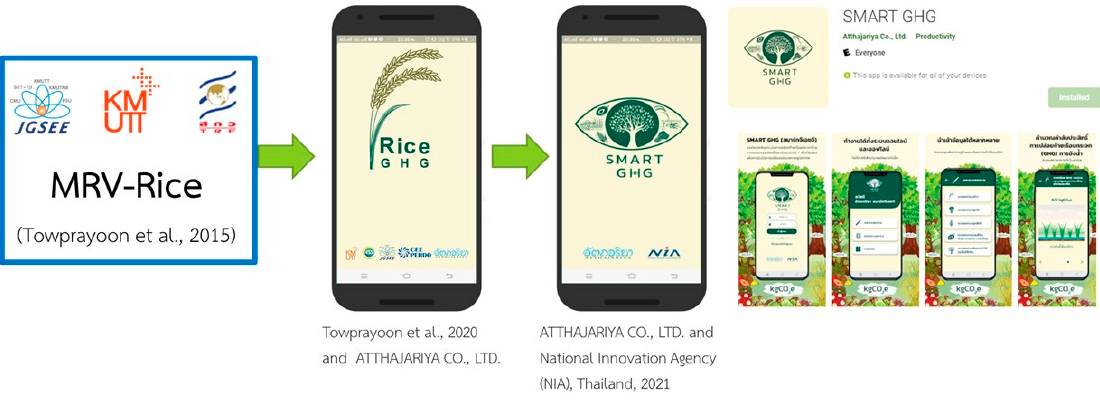
Figure 1. SMART GHG application development sequence [7,16].